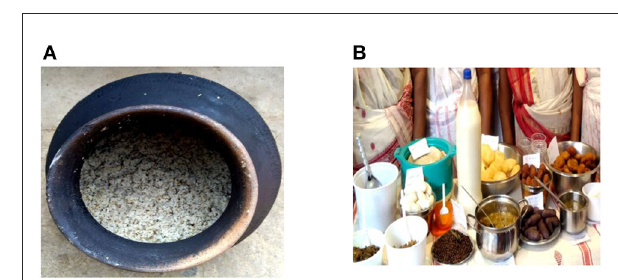
50 ml of handia daily, which highlights the cultural significance of this traditional beverage in their community. The adult male member of the family consumes a good amount of handia before going to work. School-aged children also consume handia occasionally, primarily during festivals and marriage